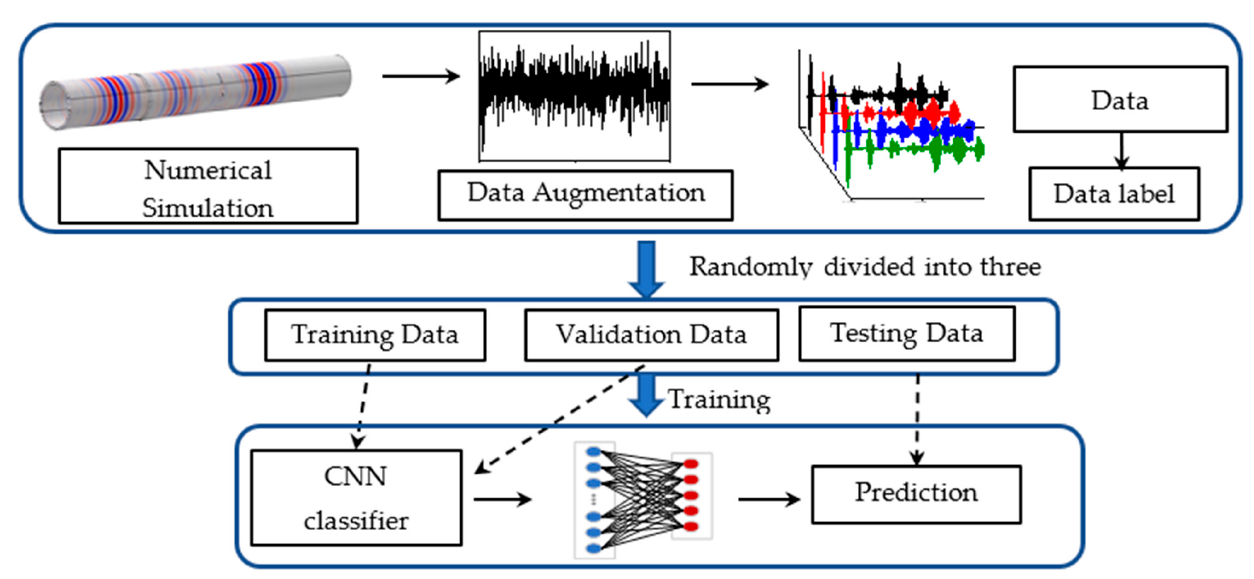
Figure 1. Flow of the proposed concept in this study.